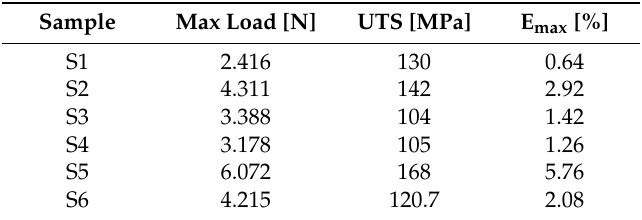
Table 6. Results from the tensile test (see Table 3 for process parameters).